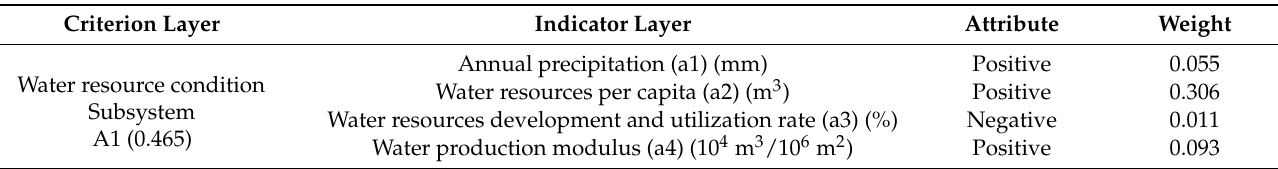
Table 2. The indicator system for sustainability assessment of water resources